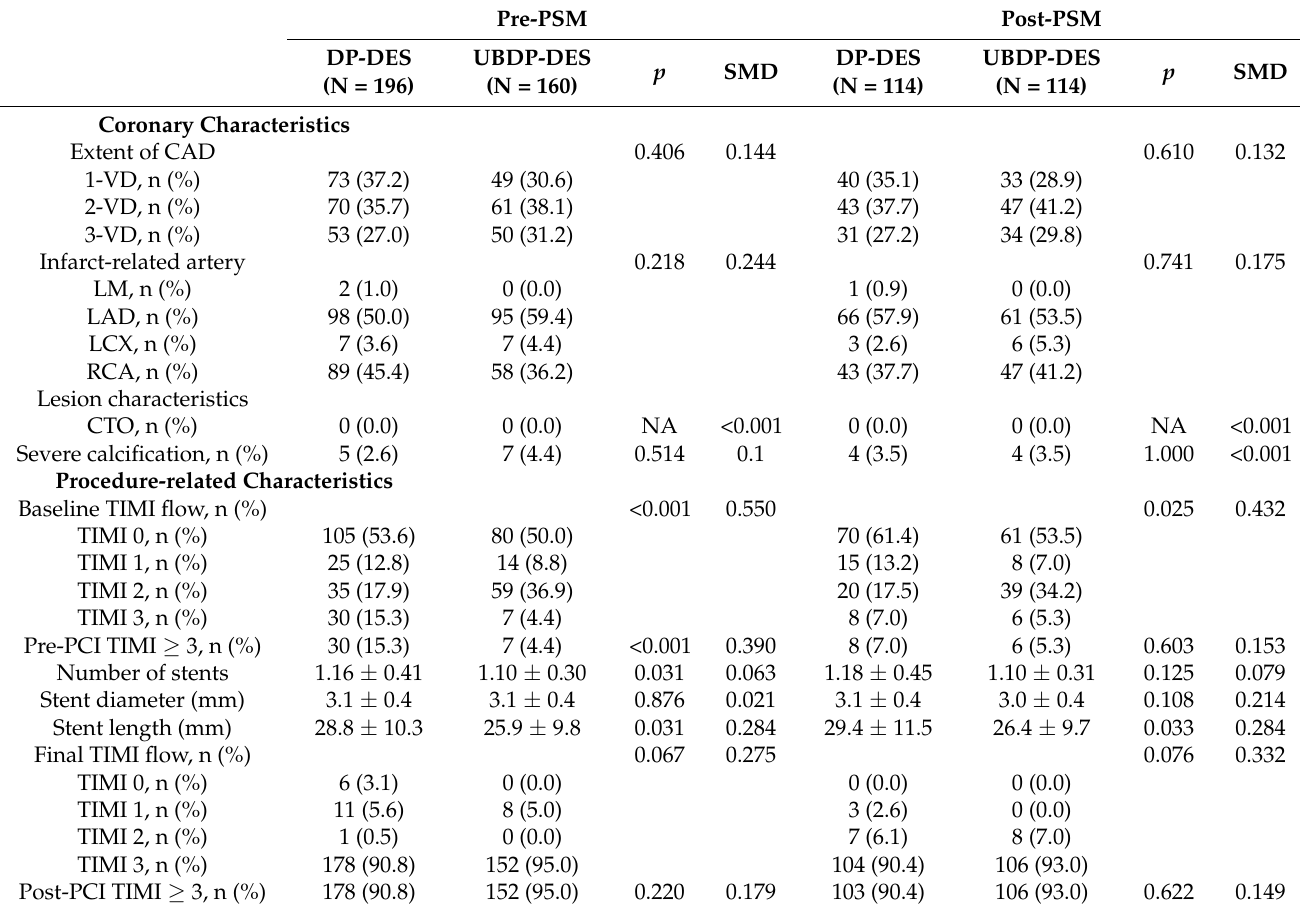
Table 2. Baseline coronary and procedure-related characteristics pre- and